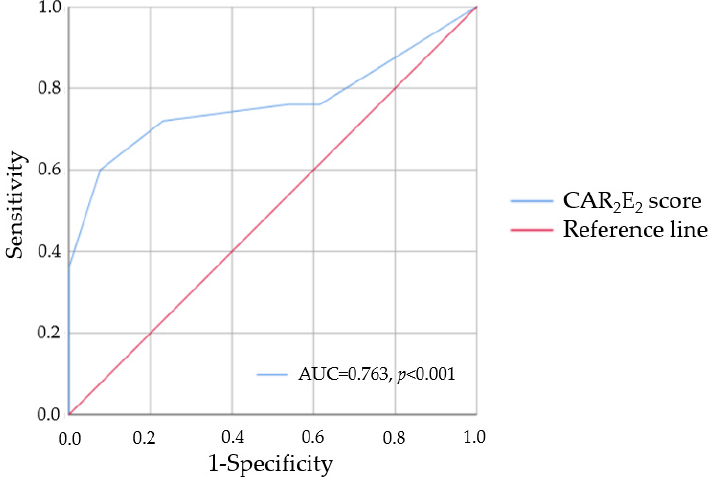
Figure 3. Area under the curve of CAR 2 E 2 score representing the predictive performance of left ventricular hypertrophy based on left ventricular mass indexed by body surface area. AUC—area under the curve.